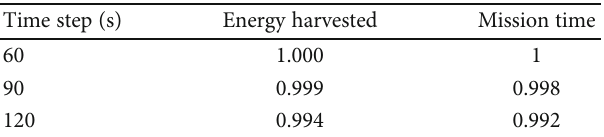
Table 2: In fl uence of time step on energy and mission time (normalized to time step